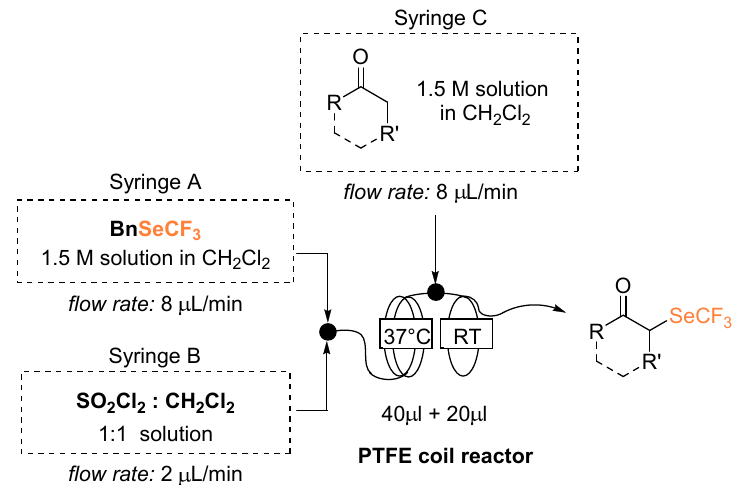
Figure 1. α -Trifluoromethylselenolation under flow conditions. Reaction temperature 1st step: 37 °C, 2nd step: RT. Flow rate inlet A and C: 8 µ L/min, inlet B: 2 µ L/min; total flow rate: 18 µ L/min. Residence time 1st reactor 4 min; 2nd reactor 1.1 min; total residence time 5.1 min.